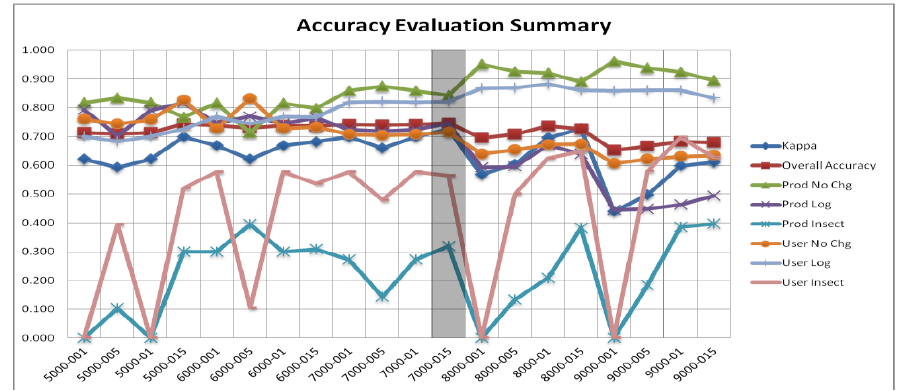
Figure 7. Accuracy evaluation summary results from all iterations of adjusted classification tree splits for each path/row. We selected iteration 7000-015 (DI’ threshold of −7000 and p -value of 0.015; the vertical grey shaded portion of the plot) because it had the greatest combination of evaluation metrics, including overall accuracy, kappa statistic and producer’s and user’s accuracies for all